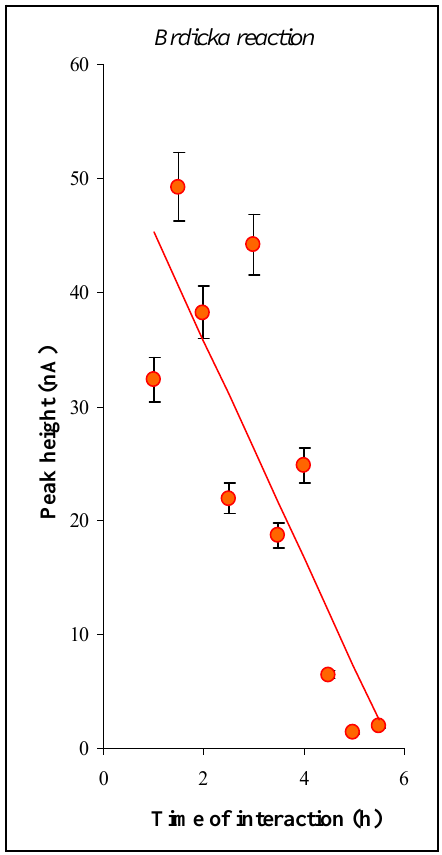
Figure 3. The changes of catalytic Cat2 peak height during MT (10 µg mL -1 ) interaction with cisplatin (100 µg mL -1 ), n =